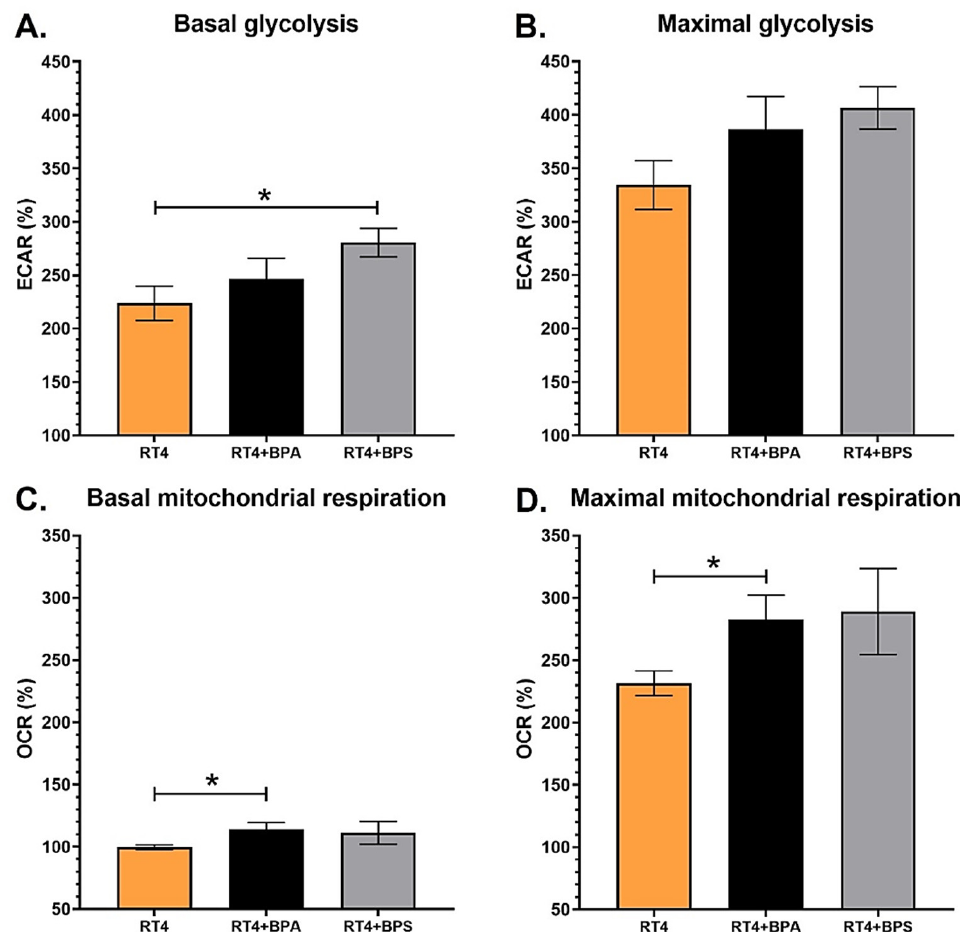
Figure 3. RT4 non-invasive bladder cancer cells chronically exposed to physiological concentrations of BPs exhibit increased bioenergetics. ( A , B ) ECAR and ( C , D ) OCR were determined using the XFe96 Extracellular Flux Analyzer for RT4 non-invasive bladder cancer cells with or without chronic exposure to physiological concentrations of BPA or BPS to establish ( A ) basal glycolysis, ( B ) maximal glycolytic capacity, ( C ) basal mitochondrial respiration and ( D ) maximal mitochondrial capacity. Data are presented as the mean ± SEM and displayed as percentages of controls (i.e., untreated condition) (n ≥ 3, N = 3). A baseline (100%) was established before injections (see Figure S3). * p < 0.05 by Mann–Whitney test.